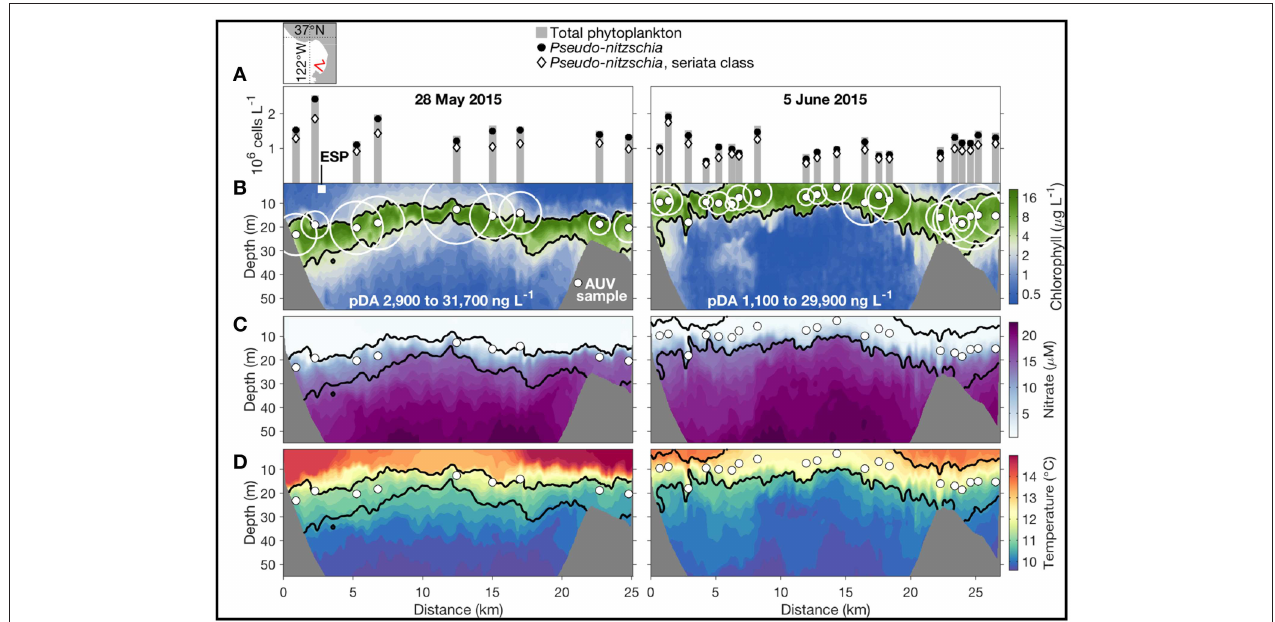
FIGURE 2 | In May-June 2015, the Dorado AUV acquired water samples precisely from the HAB layer in two missions on a transect in the southern Monterey Bay, during upwelling relaxation (left) and intensification (right). The AUV transect’s location is shown in the upper-left map. The AUV started from the southeast end of the transect. (A) Cell counts from microscopy, shown directly above the sample locations (indicated by the small solid white circles in B–D ). (B–D) Chlorophyll concentration, nitrate concentration, and temperature along the AUV transect. In (B) , the pDA concentration of each sample is represented by the size of the open white circle, and the range of pDA in each transect is noted. The position and depth of the moored 2G-ESP is indicated by the white square in (B) . Adapted from Ryan et al. (2017) with